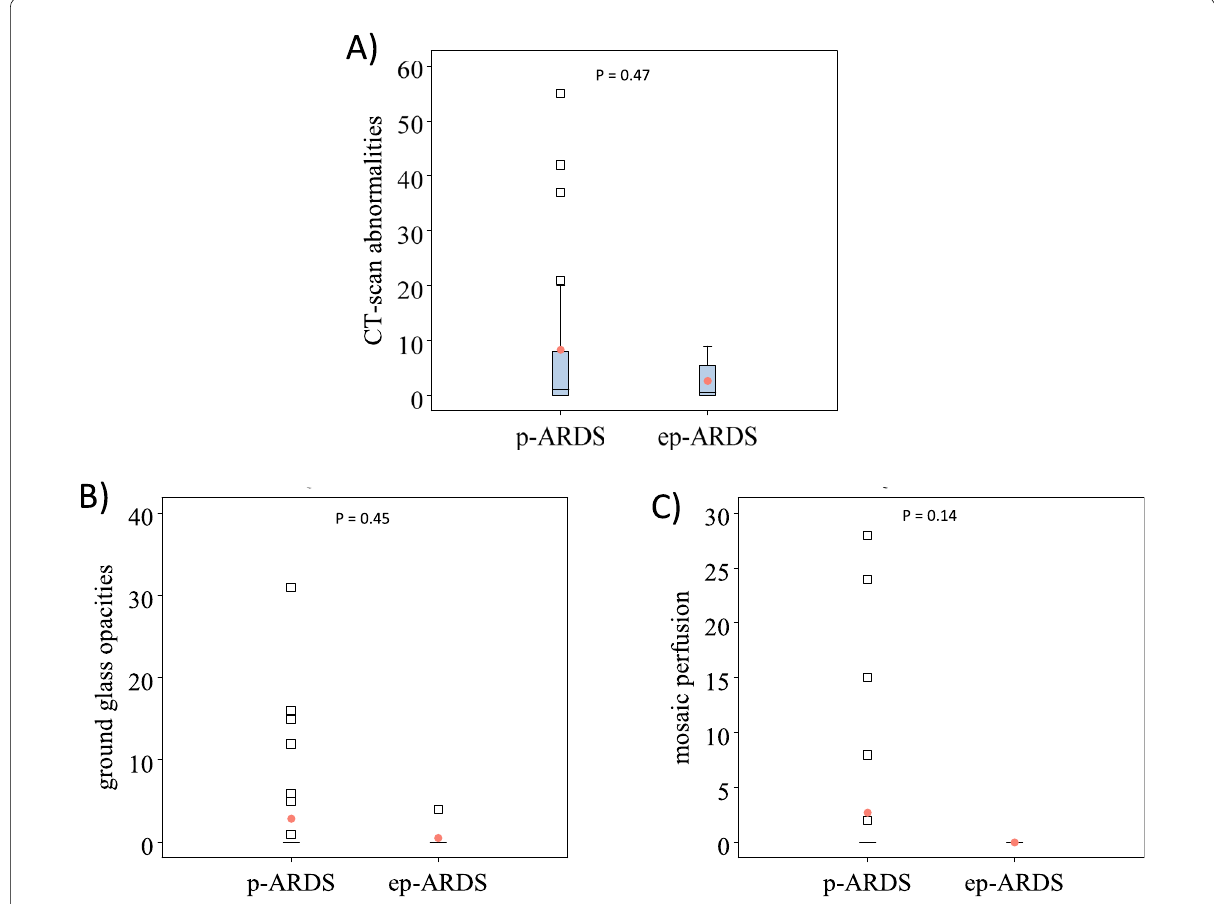
Fig. 2 A Box plot describing scores of CT‑scan abnormalities (sum of quotations), B scores of ground glass opacities and C scores of mosaic perfusion in pulmonary (p‑ARDS) and extra‑pulmonary ARDS